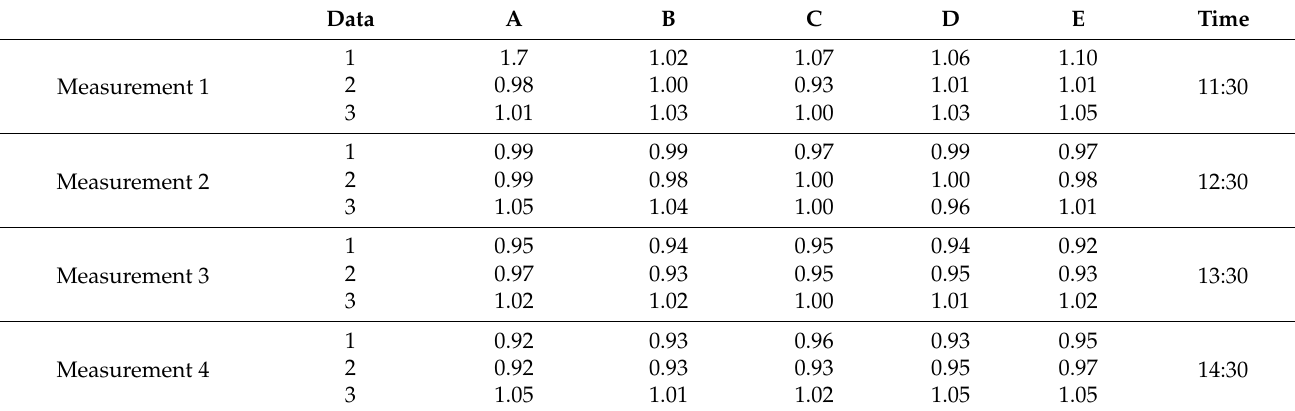
Table 2. Radiation ratios obtained in canal and galvanized steel side panels.